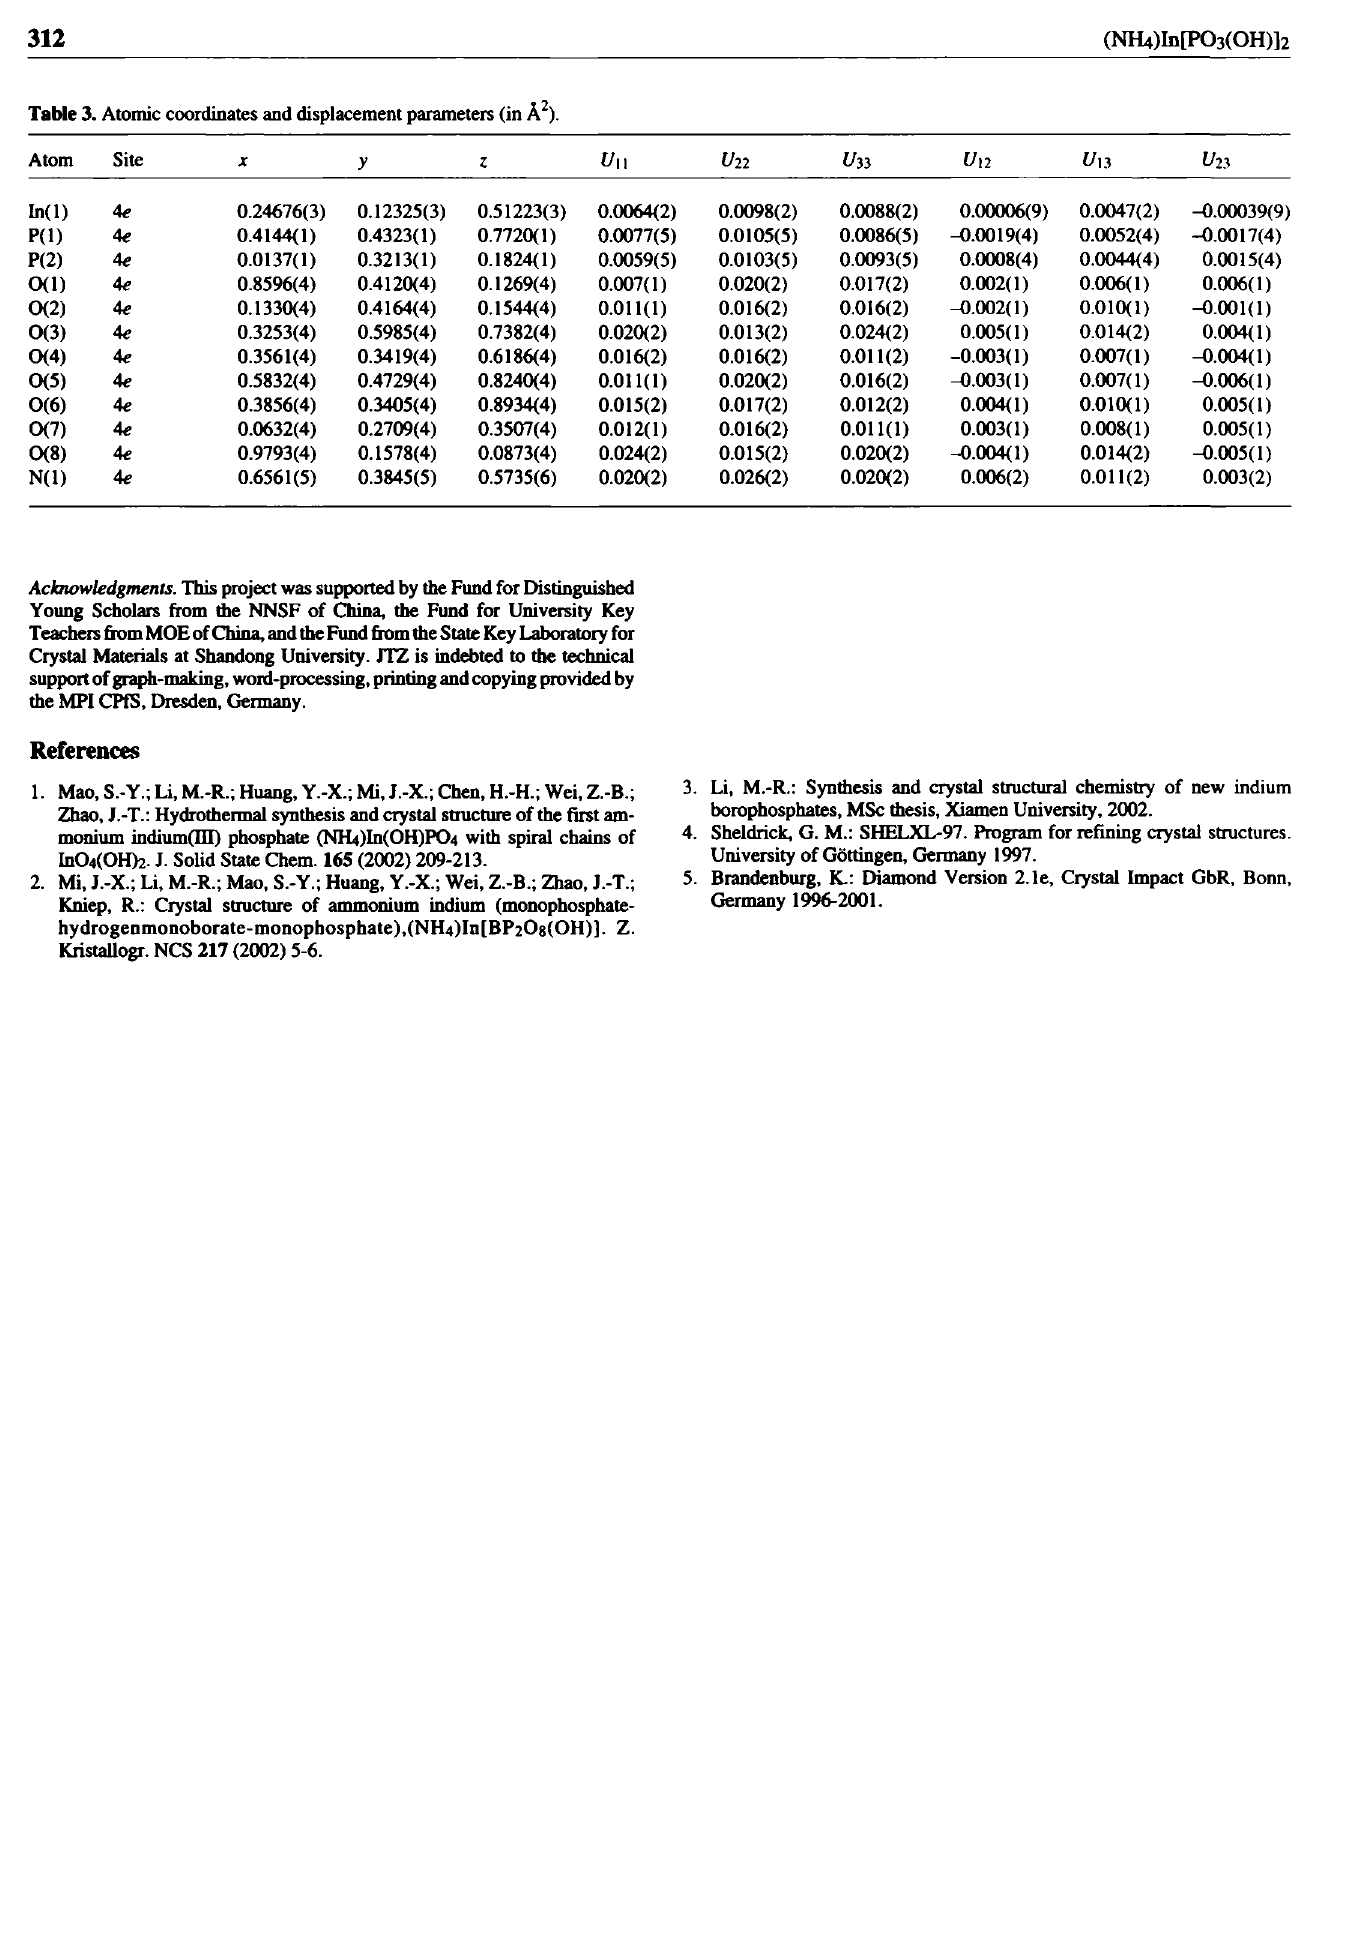
Table 3. Atomic coordinates and displacement parameters (in Â 2